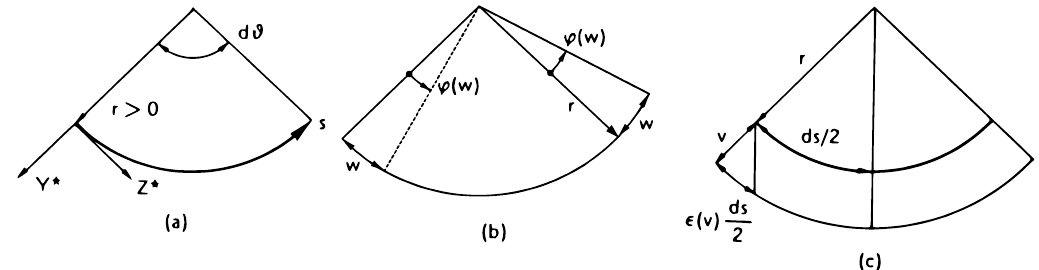
Figure 2: Curved beam element: (a) reference system, (b) rigid rotation to be subtracted from the total one and due to a uniform tangential displacement, (c) additional axial dilation due to a uniform radial displacement.